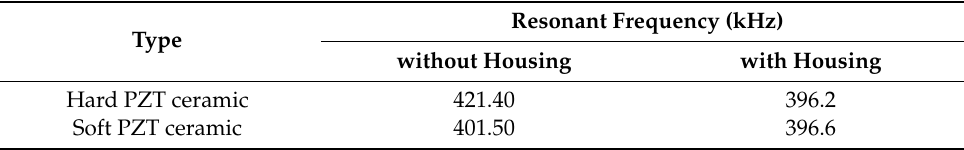
Table 2. Change of resonant frequency before and after housing connection.